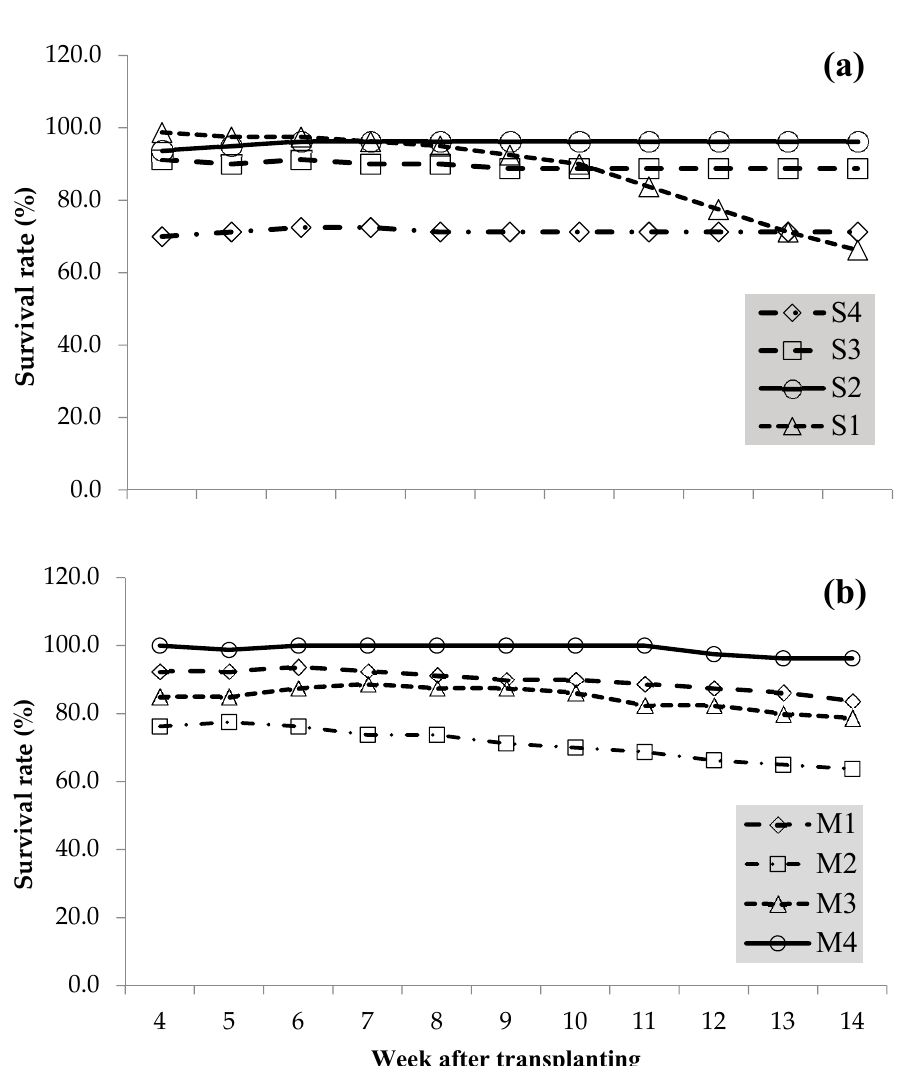
Figure 2. Survival rate of Avicennia marina (Forssk.) Vierh. seedlings in a controlled environment: ( a ) salinity (S) and ( b ) medium composition (M). (S1: salinity < 5 ppt, S2: 5–15 ppt, S3: 15–25 ppt, and S4: 25–35 ppt; M1: original sedimentary soil and sand (100:0), M2: 50:50, M3: 25:75, and M4: 0:100).